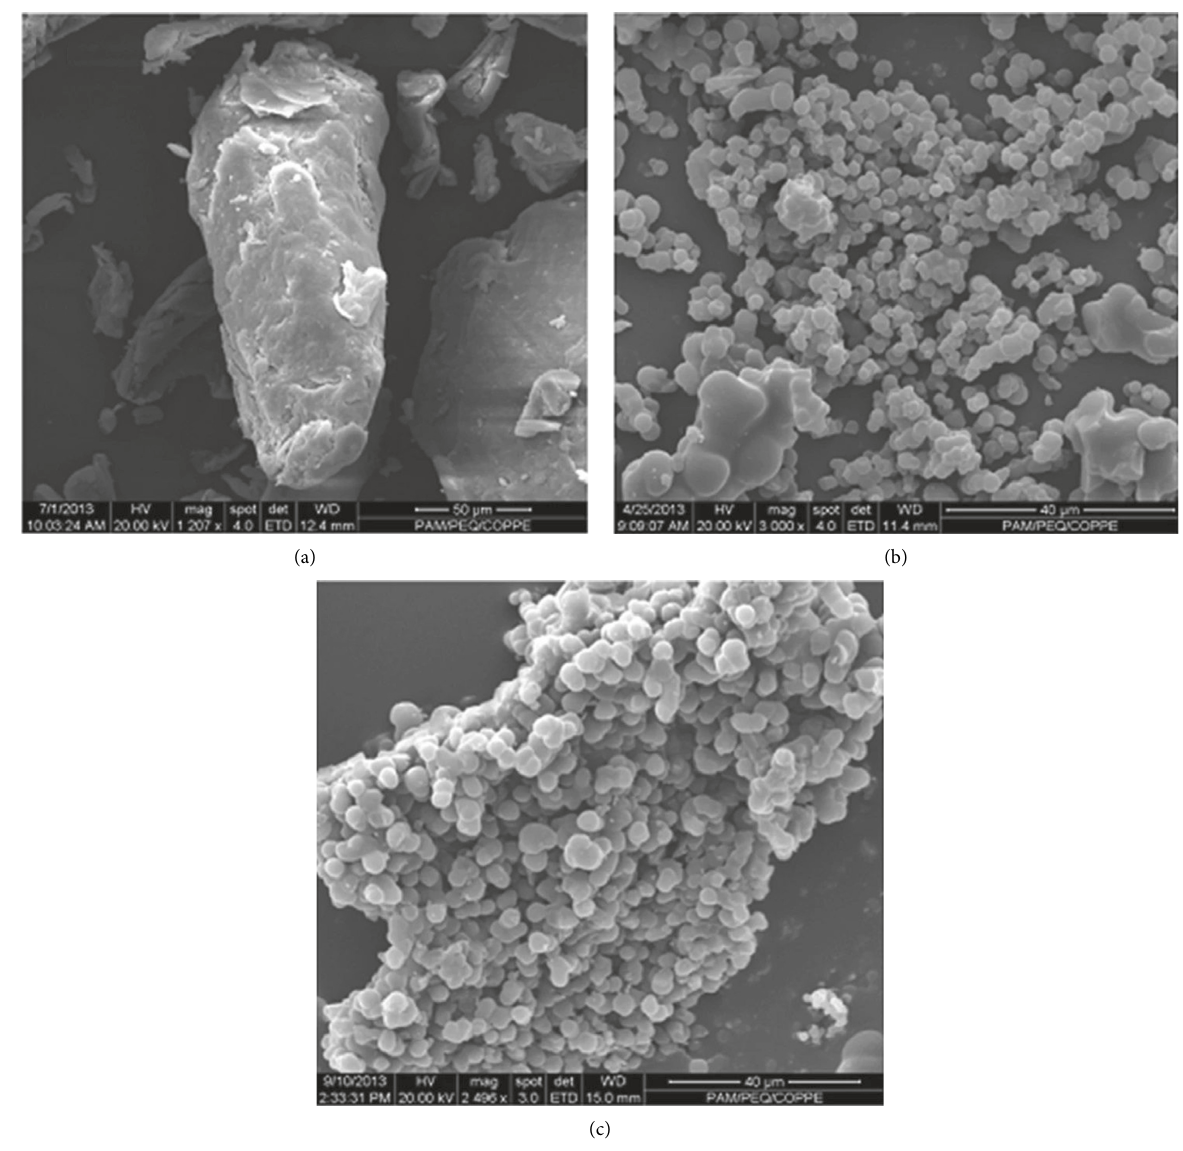
Figure 4: SEM thermograms of the K-carrageenan